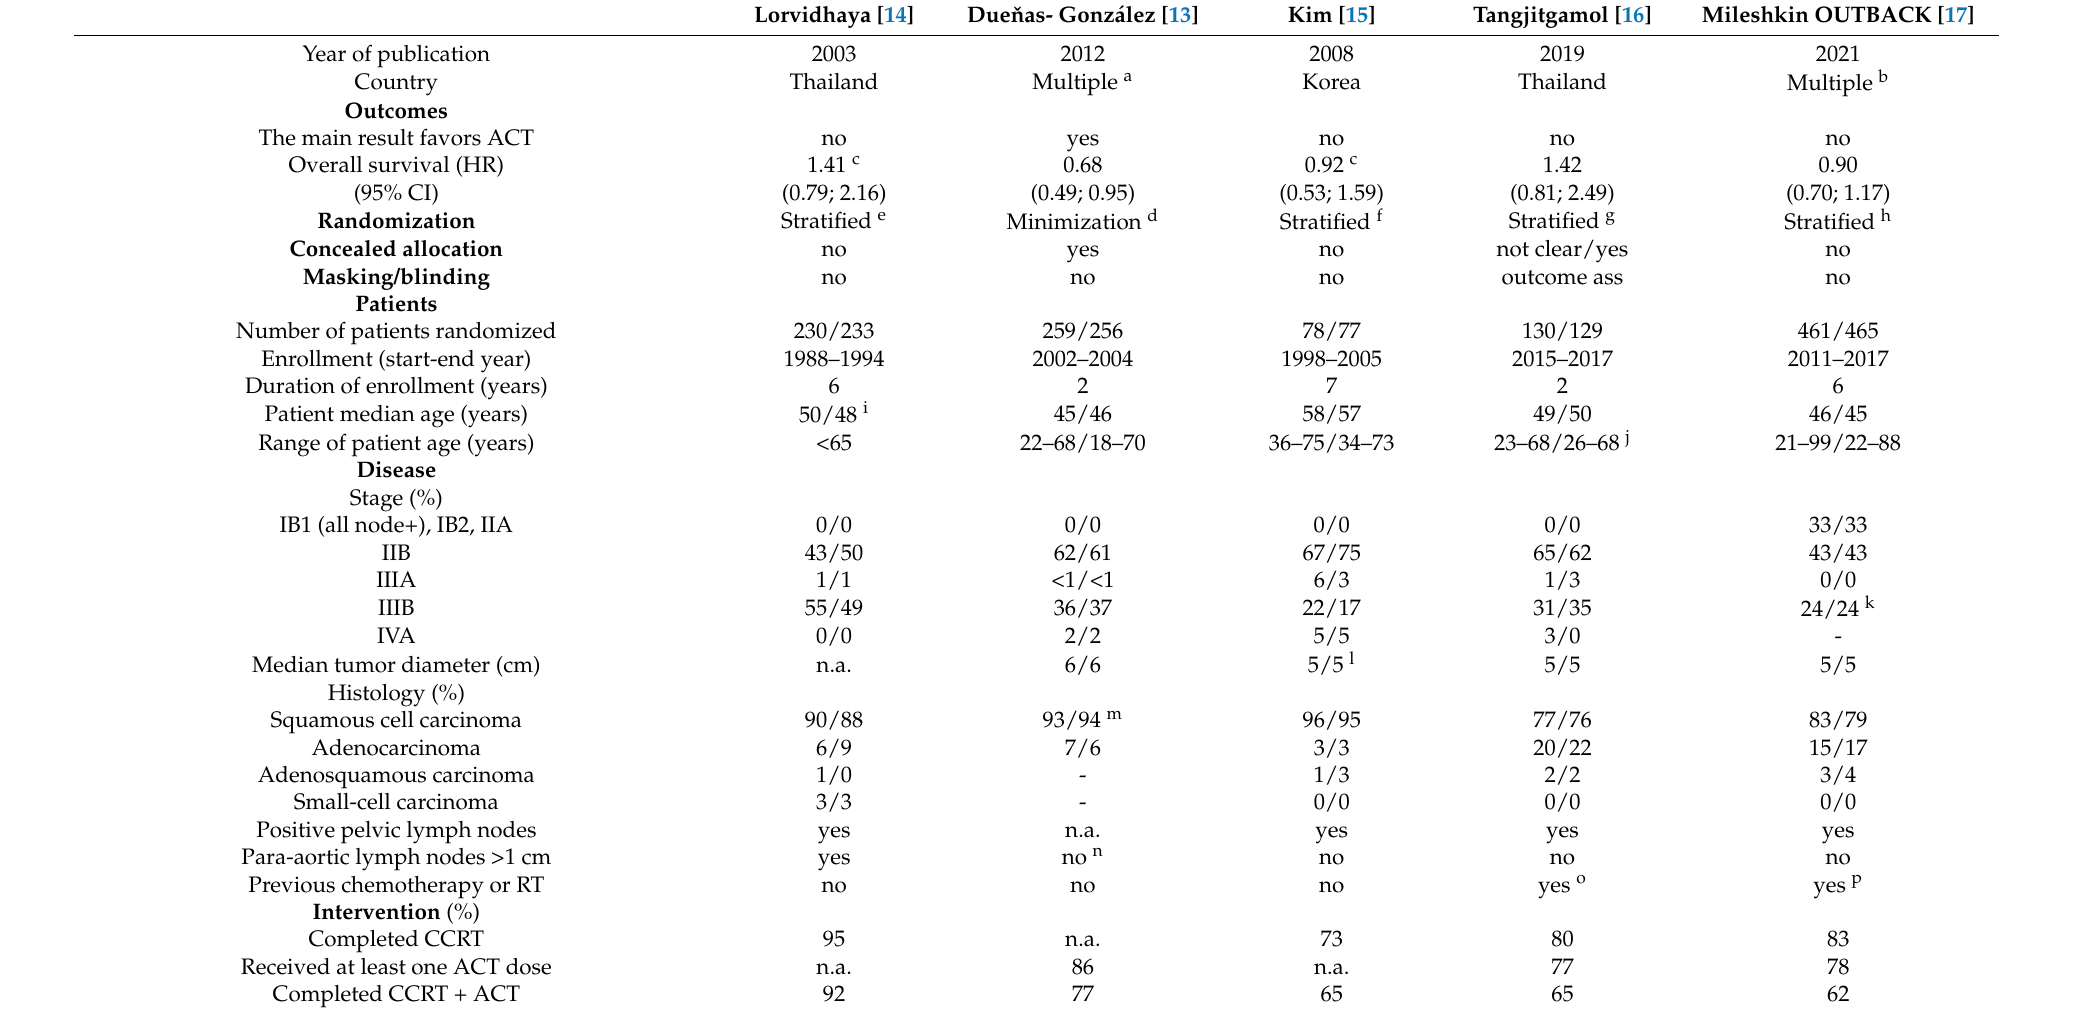
Table 1. Overview of included randomized controlled trials sorted by year of the end of